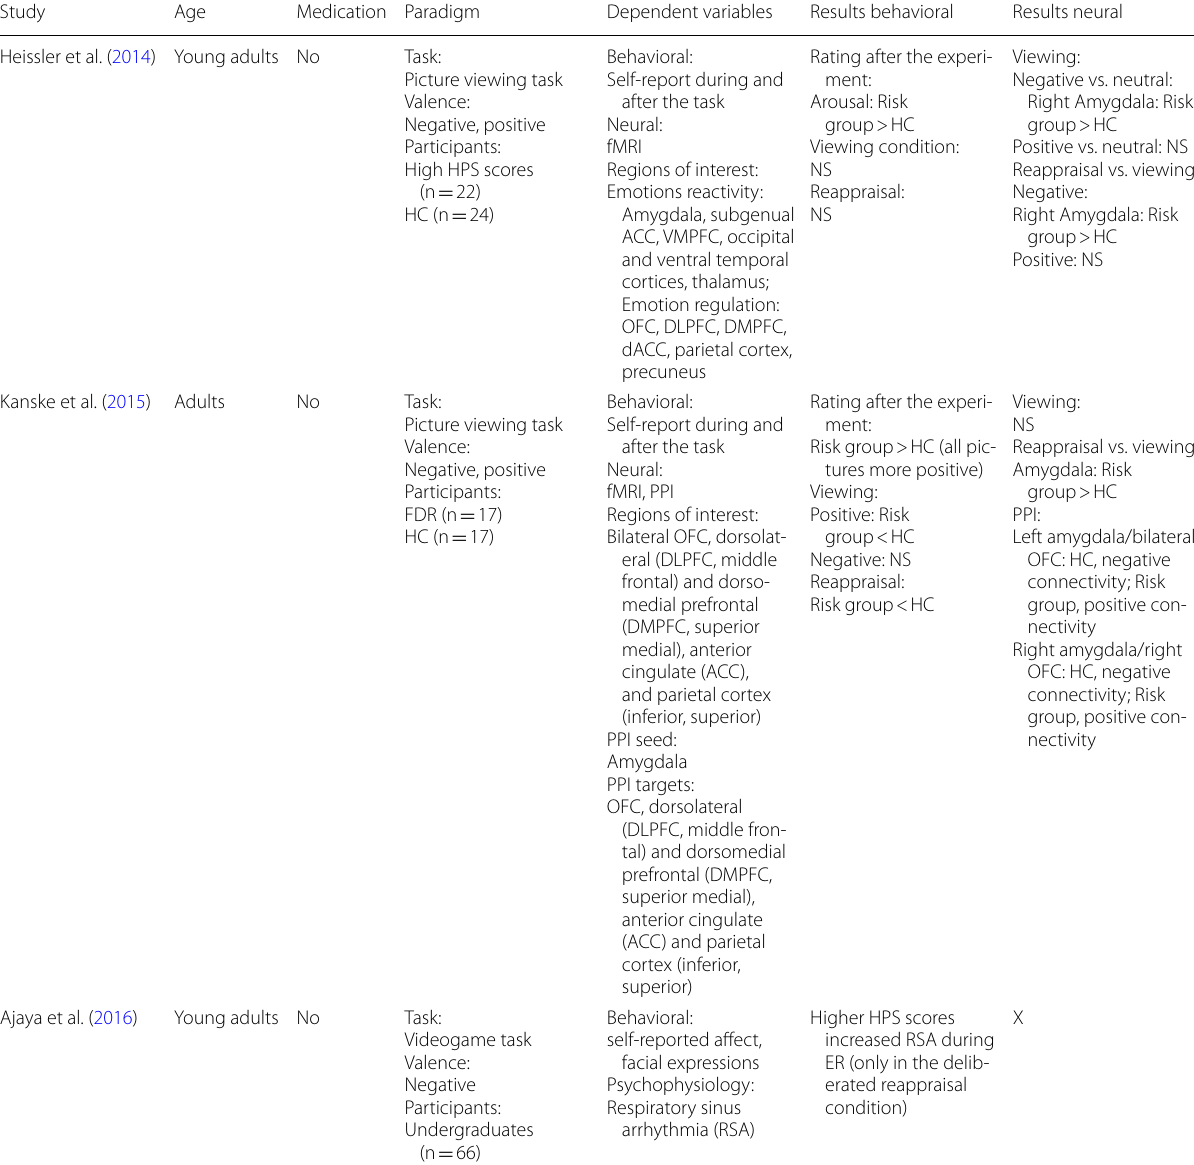
Table 4 Studies that investigated reappraisal in risk